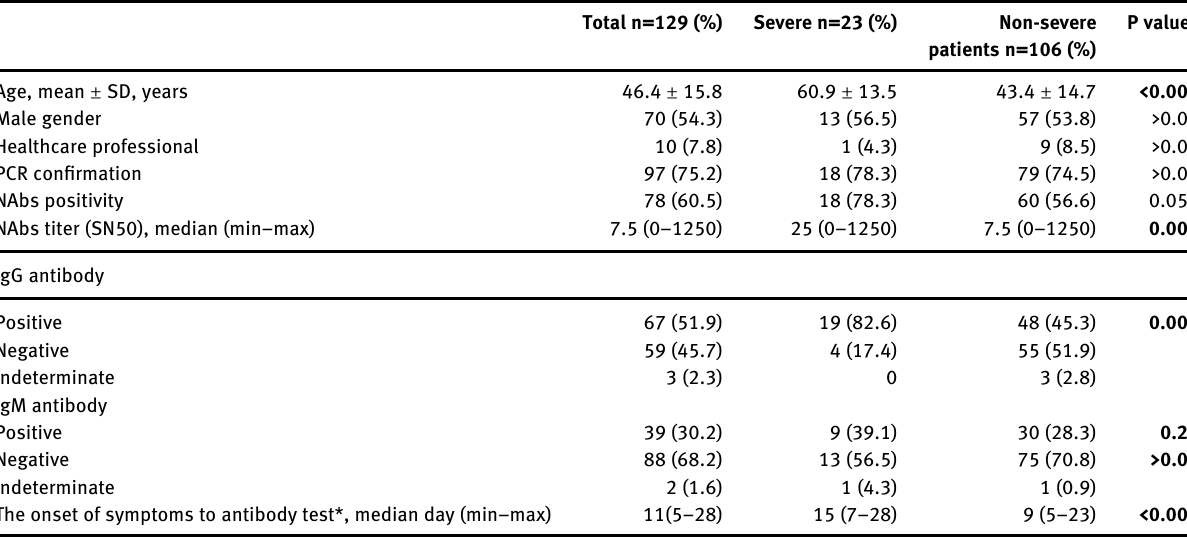
(Table1). The distribution of NAb titers obtained in the discharge serum of the patients were plotted by age, gender, disease severity, and chest CT findings at the time of admission (Figure 2). Age and gender had no signi fi cant impact on NAb titers (Figure 2A and B). The median NAb titer (SN was 1:25 (interquartile range (IQR) 1:42.5) in severe patients